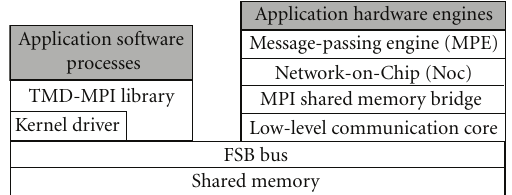
Figure 3: HW/SW abstraction